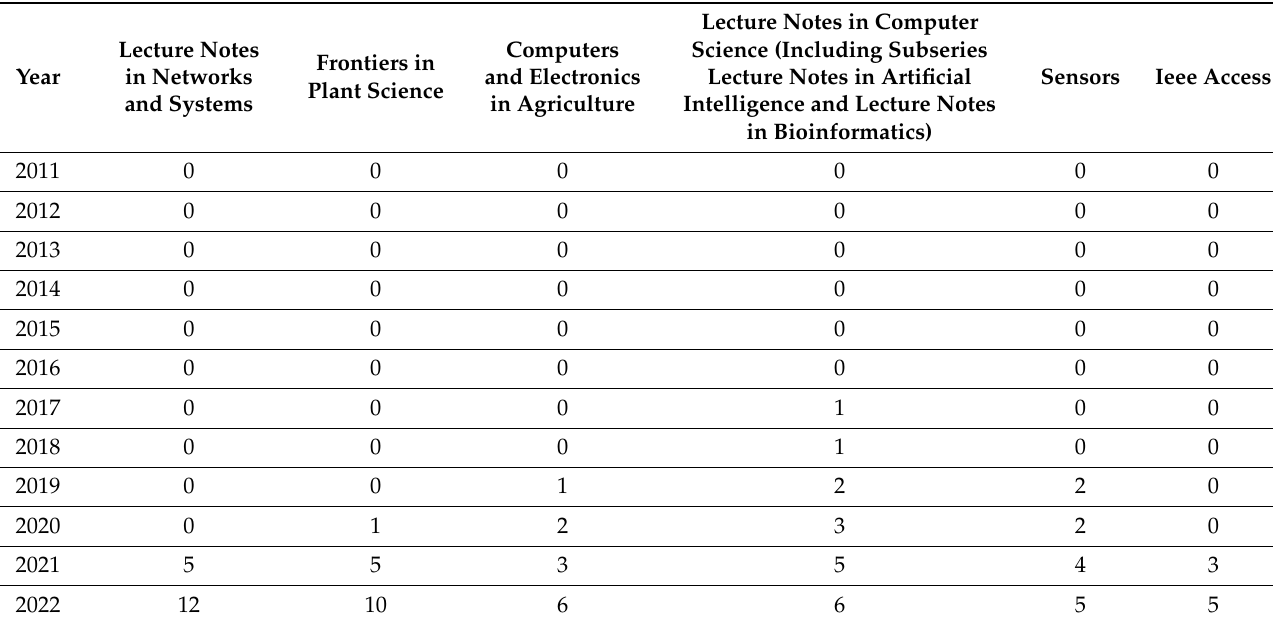
Table 3. Annual Dynamic Occurrences of Articles Year Wise of Apple Leaves